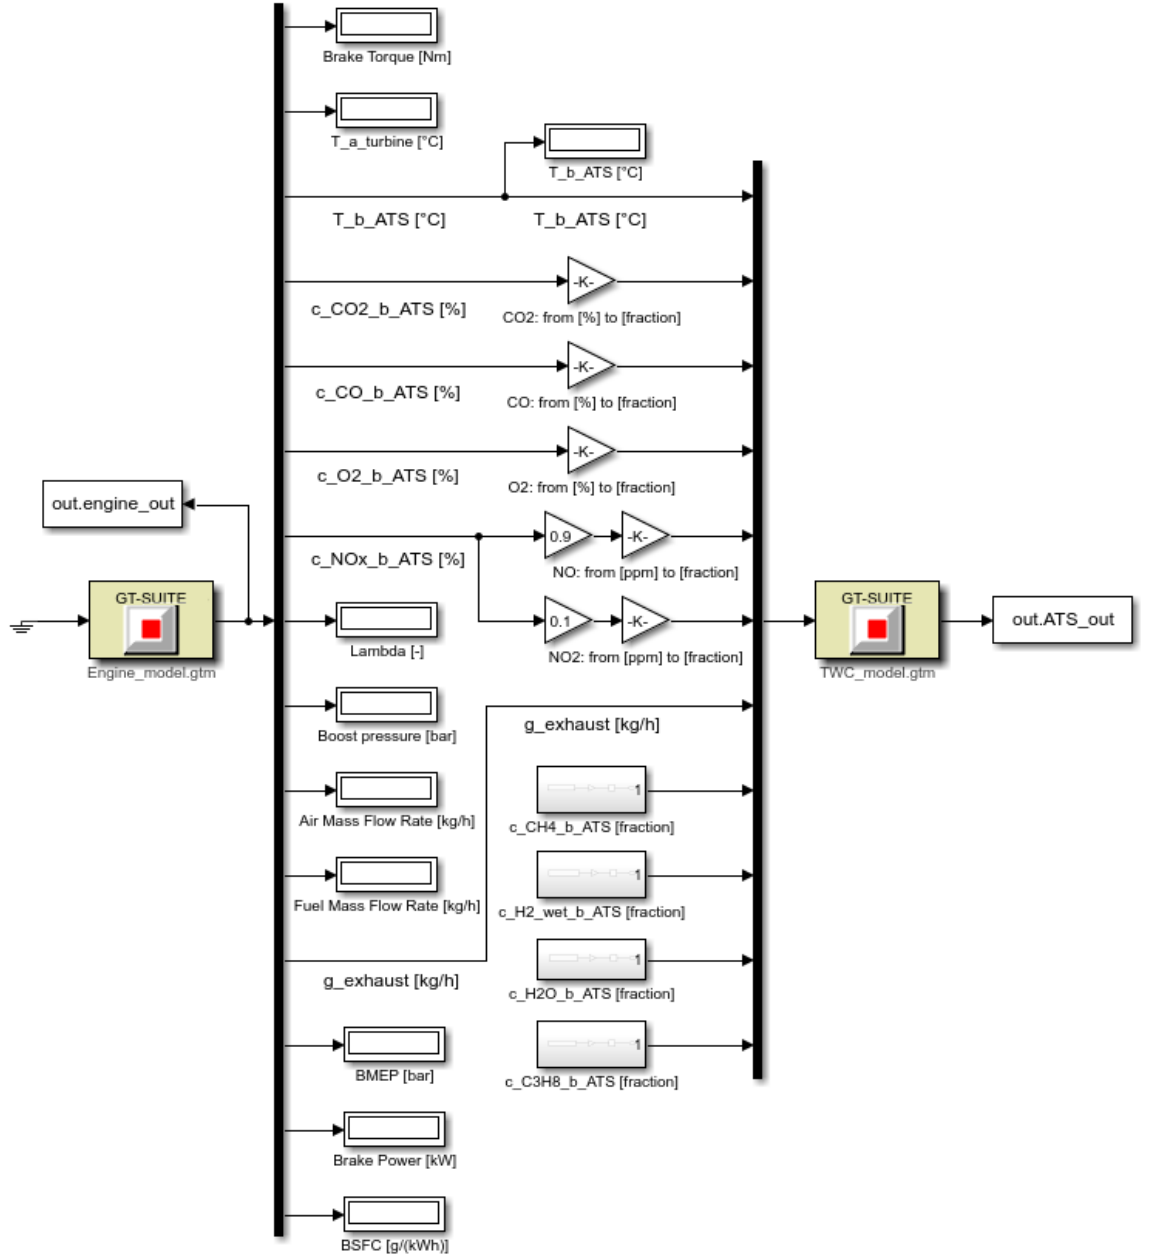
Figure 9. Detail of the link between the engine model and the variables implemented in Simulink.